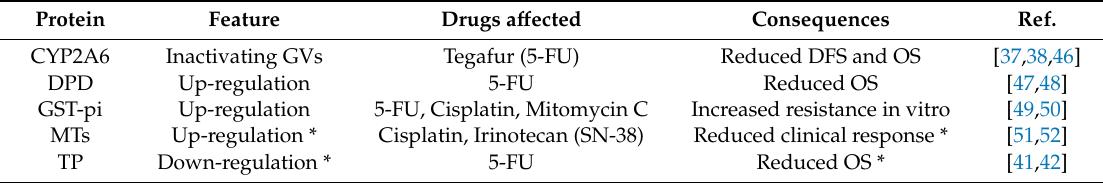
Table 2. Mechanisms of chemoresistance type 2 (MOC-2) to drugs used in the treatment of GAC. Protein Feature Drugs a ff ected Consequences Ref. CYP2A6 Inactivating GVs Tegafur (5-FU) Reduced DFS and OS [37,38,46] DPD Up-regulation 5-FU Reduced OS [47,48] GST-pi Up-regulation 5-FU, Cisplatin, Mitomycin C Increased resistance in vitro [49,50] MTs Up-regulation * Cisplatin, Irinotecan (SN-38) Reduced clinical response * [51,52] TP Down-regulation * 5-FU Reduced OS * [41,42] 5-FU, 5-Fluorouracil; DFS, disease-free survival; GV, genetic variant; OS, overall survival; *, Contradictory